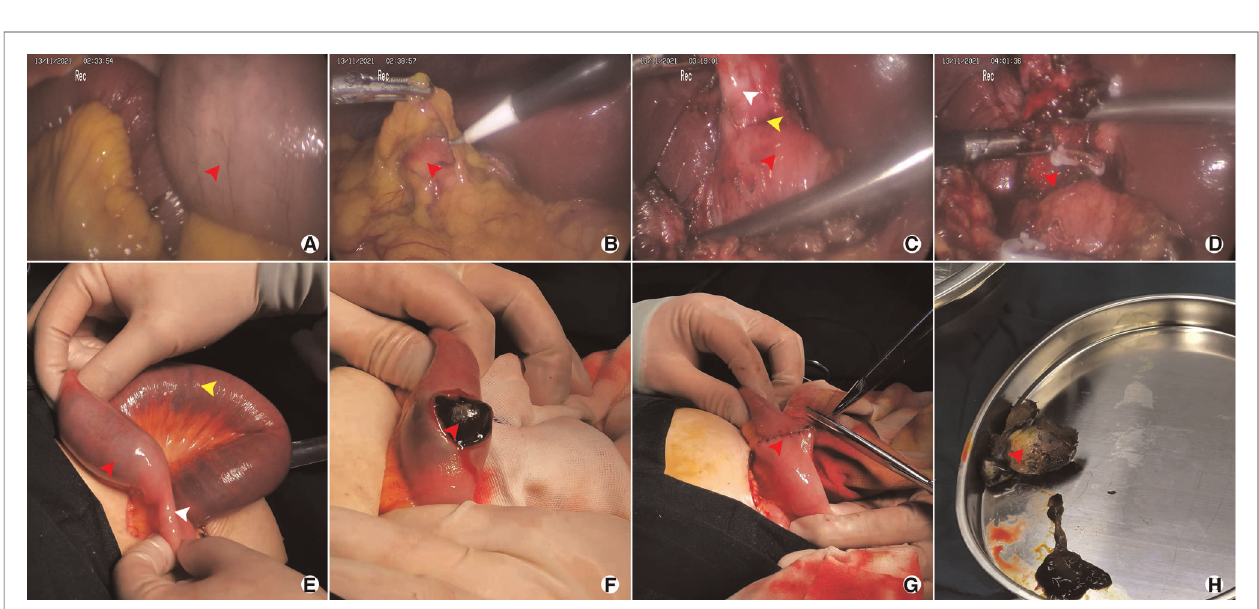
FIGURE 2 | Contrast-enhanced CT and MRCP images showing the characteristics of a 57-year-old female who was diagnosed with both CDF and CGF; (A) CT image of Pneumobilia (red arrow); (B) CT image showing ill-de fi ned borderline between gallbladder and digestive tract (marked in the red box); (C) MRCP image showing Pneumobilia (red arrow); (D) MRCP image of ill-de fi ned borderline between gallbladder and digestive tract (marked in the red box); (E) Reconstruction of MRCP showing Pneumobilia and fi stula (white arrow).